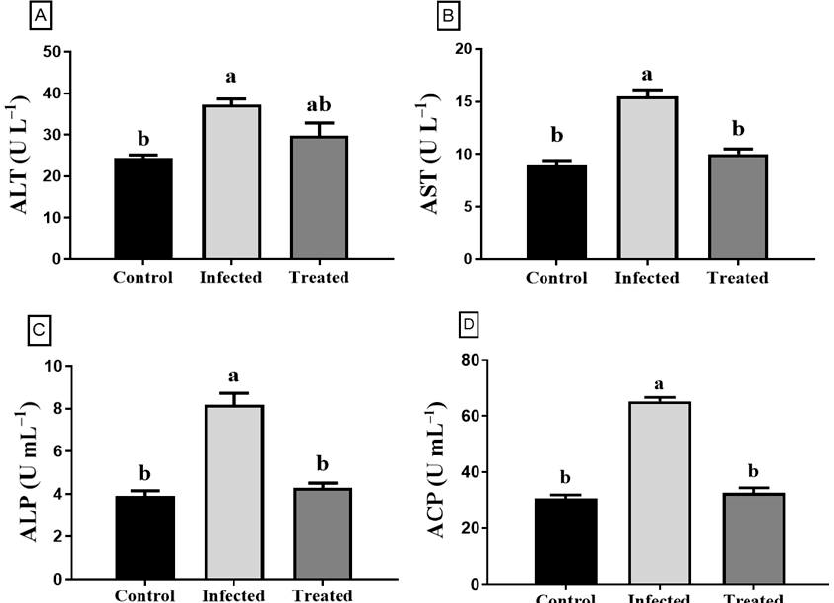
Figure 6. Alanine aminotransferase (ALT; ( A )), aspartate aminotransferase (AST; ( B )), alkaline phosphatase (ALP; ( C )), and acid phosphatase (ACP; ( D )) activities of infected Litopenaeus vannamei with Vibrio spp. and those treated with florfenicol antibiotic. Values are expressed as the mean ± SME (n = 6 per group). Means with different superscripts are significantly different ( p < 0.05). Lysozyme activity ( t = 10.17; df = 8; p < 0.0001), SOD ( t = 11.91; df = 8; p < 0.0001), and GSH ( t = 6.14; df = 8; p = 0.0003) indexes were significantly lower in Vibrio -infected shrimp ( p < 0.001) than in the control group (Figure 7). The treatment with florfenicol elevated the lowered levels of lysozyme ( t = 6.20; df = 8; p = 0.0003), SOD ( t = 8.76; df = 8; p < 0.0001), and GSH ( t = 5.58; df = 8; p = 0.0005) caused by Vibrio infections as demonstrated in the treated group when compared to the infected group (Figure 7).